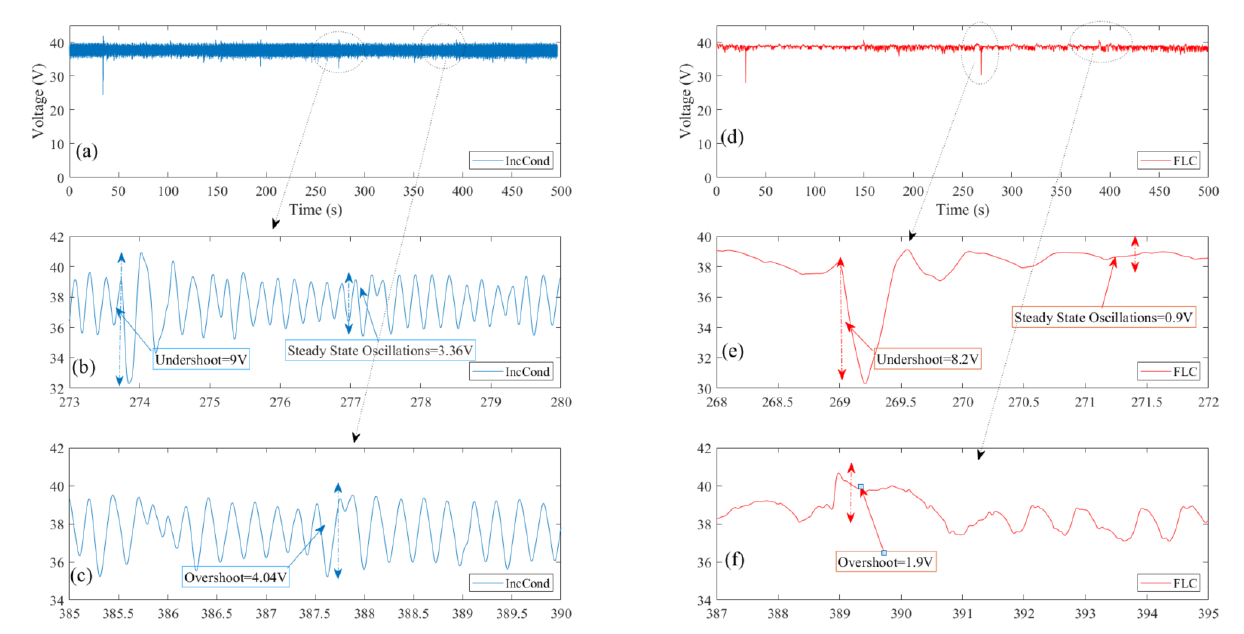
Figure 9. PV panel voltage signals correspond to the maximum power point: ( a ) voltage signal under the use of the IncCond; ( b ) influence of the first load variation for the case of the IncCond; ( c ) influence of the second load variation for the case of the IncCond; ( d ) voltage signal under the use of the FLC; ( e ) influence of the first load variation for the case of the FLC; and ( f ) influence of the second load variation for the case of the